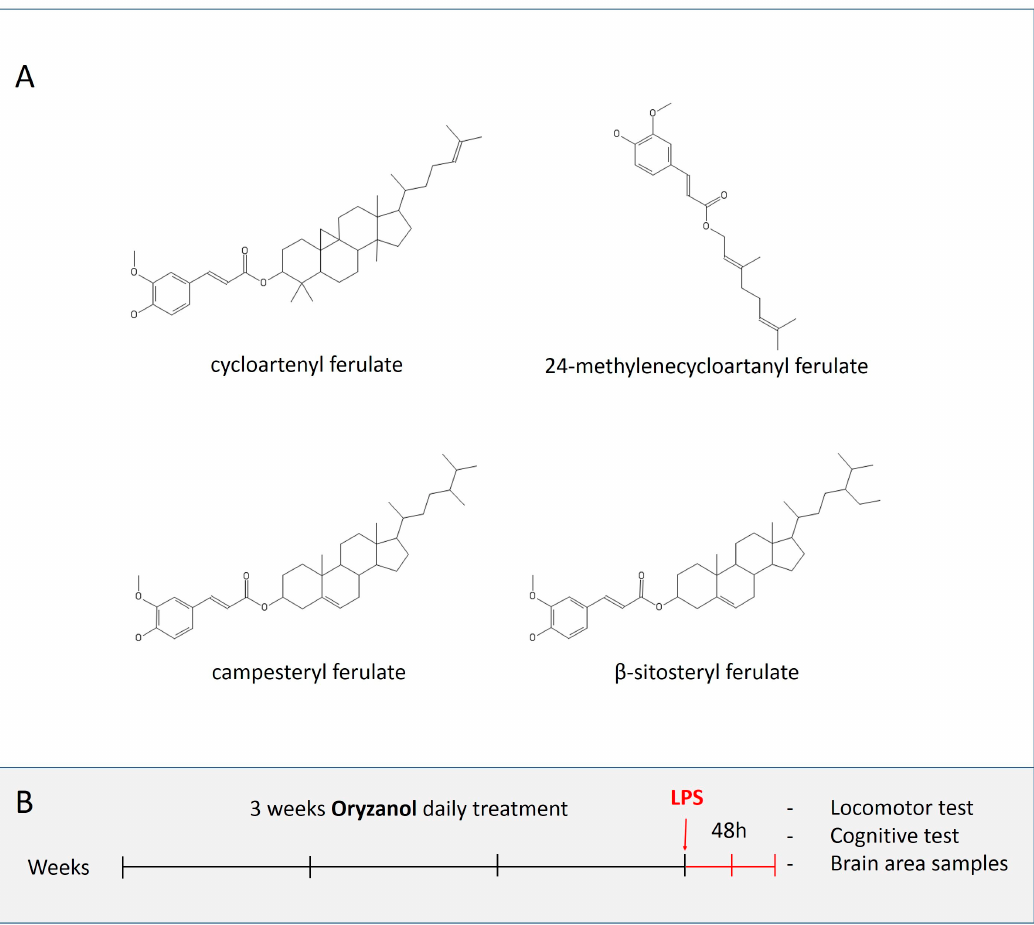
Figure 1. Chemical structures of different organic molecules contained in γ -oryzanol ( A ). Graphic scheme of γ -oryzanol and lipopolysaccharide (LPS) treatment protocol ( B ).